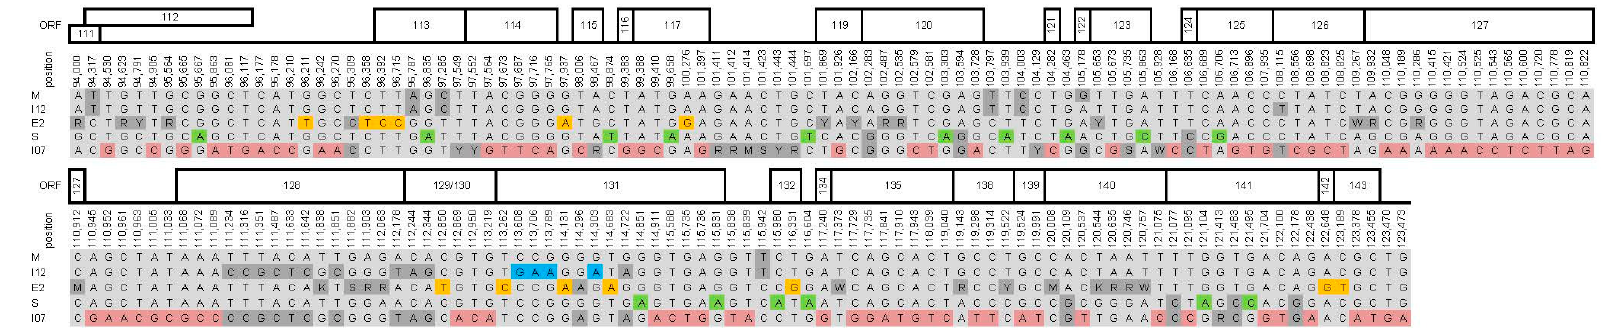
Figure 3. Alignment of all 788 SNP positions covered by all five CpGV isolates. Positions refer to the reference sequence CpGV-M, as well as the ORF numbers on top of the alignment. Red: SNPs specific for CpGV-M (=2), blue: SNPs specific for CpGV-I12 (=21), orange: SNPs specific for CpGV-E2 (=54), green: SNPs specific for CpGV-S (=101), light red: SNPs specific for CpGV-I07 (=356), dark grey: unspecific (=116) and ambiguous (=137) SNP positions, light grey = SNP shared by three or four isolates. Position 20,144 was specific for CpGV-S and CpGV-I07. Ambiguities: R (A or G), Y (C or T), S (G or C), W (A or T), M (A or C) and K (G or T).